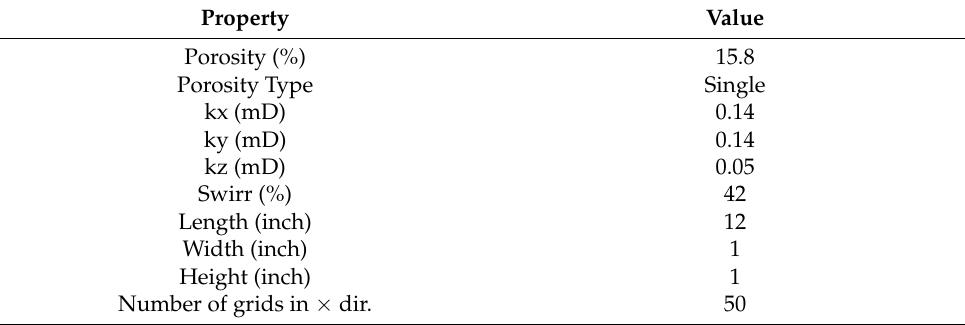
Table 6. Basic rock and petrophysical properties.